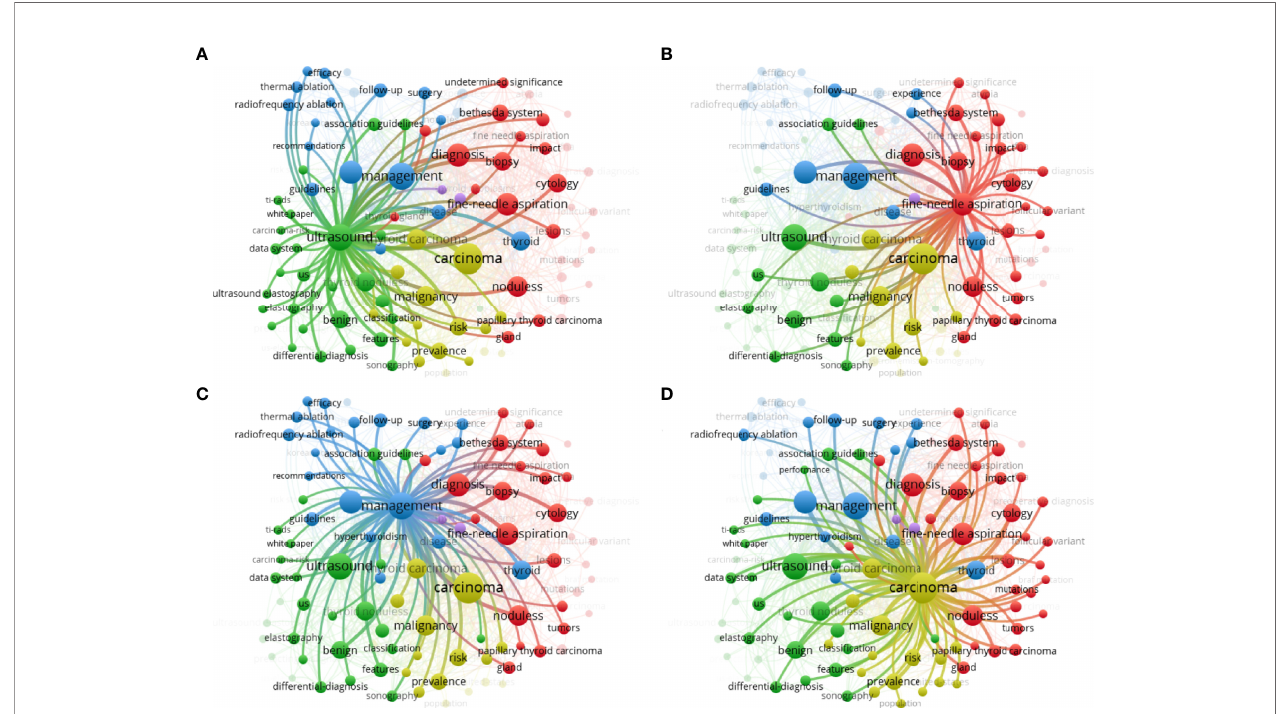
FIGURE 4 | Top 100 most stated keywords represented by the visualization of citation networks. The importance of the topics is shown through the size of the circle. The weight of connections among the topics is also shown as the thickness of the line between the circles. The focalization in the blue cluster (management)